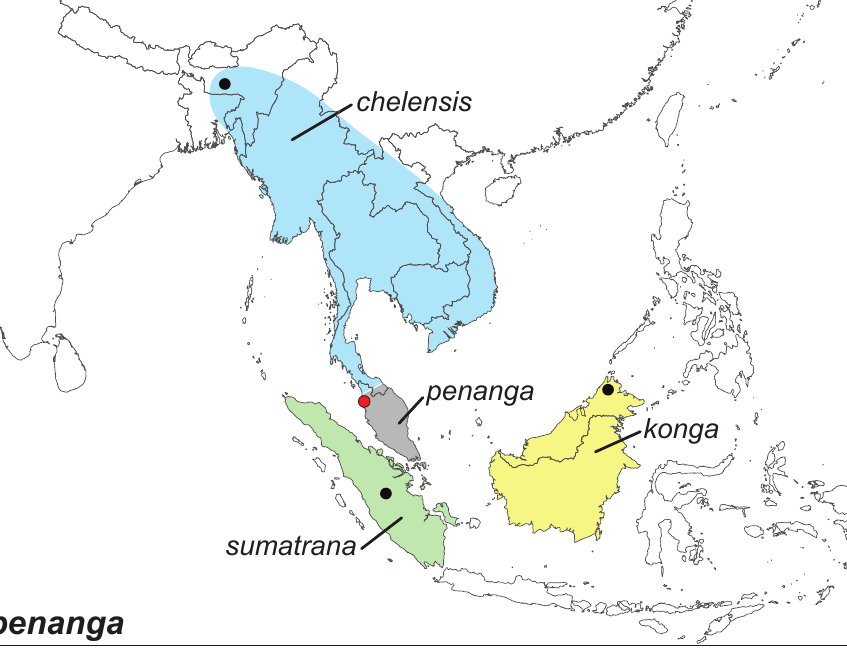
Figure 39. Distribution map of Elymnias penanga .